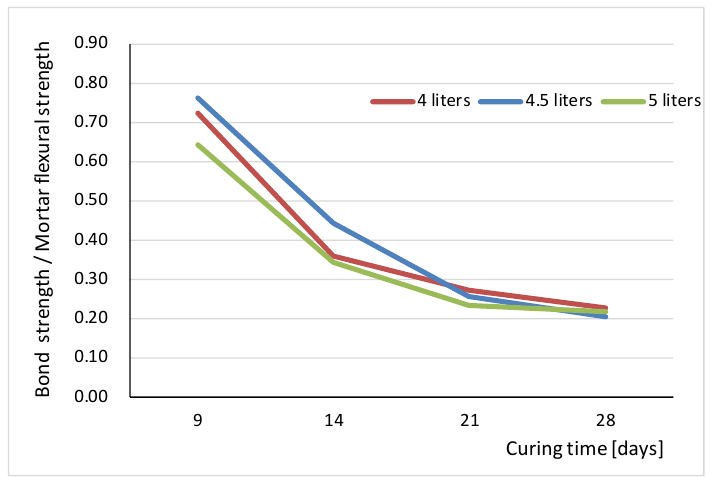
Figure 6. Comparison of average values of bond strength with flexural strength of the mortar for all tested series.